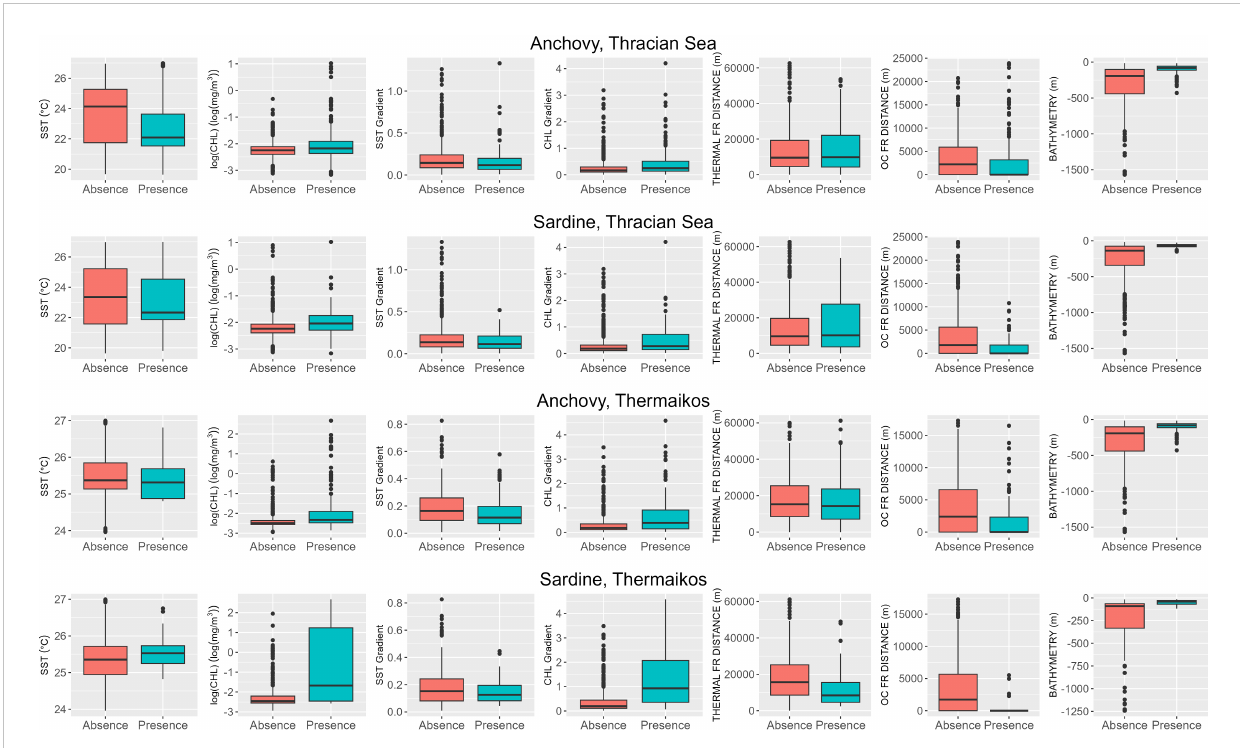
FIGURE 4 Boxplots between the classi fi ed in-situ measurements and all the independent variables for each species and each area. Orange is for ‘ Absence ’ , and Green is for ‘ Presence ’